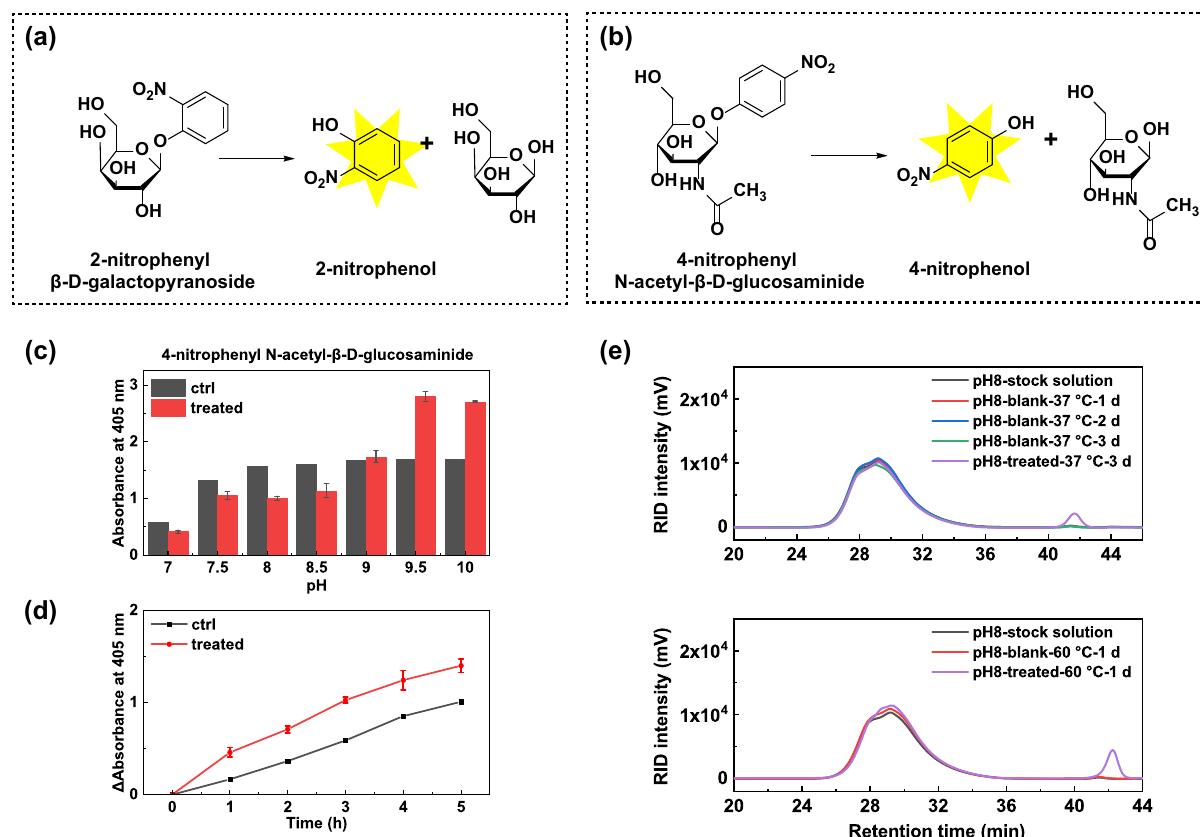
Fig. 5 Glycosidase-like activity of Ce-FMA-FA-20-RT. a and b Schematic illustration of hydrolysis and the detection principle of 2-nitrophenyl β - D - galactopyranoside in a and 4-nitrophenyl N -acetyl- β - D -glucosaminide in b . c The optical density at 405nm of hydrolysed product of 4-nitrophenyl N -acetyl- β - D - glucosaminide under different pHs at 60°C for 8h. Data are presented as mean±standard error of the mean ( n = 3). d Optical density change at 405nm of hydrolysed product of 4-nitrophenyl N -acetyl- β - D -glucosaminide under pH 10.0 bathed at 60°C for 5h. ( Δ Absorbance = Absorbance time − Absorbance 0 h ) Data are presented as mean±standard error of the mean ( n = 3). e GPC pro fi les of carboxymethyl chitosan before and after treatment with Ce-FMA-FA-20-RT at 37°C or 60°C under pH